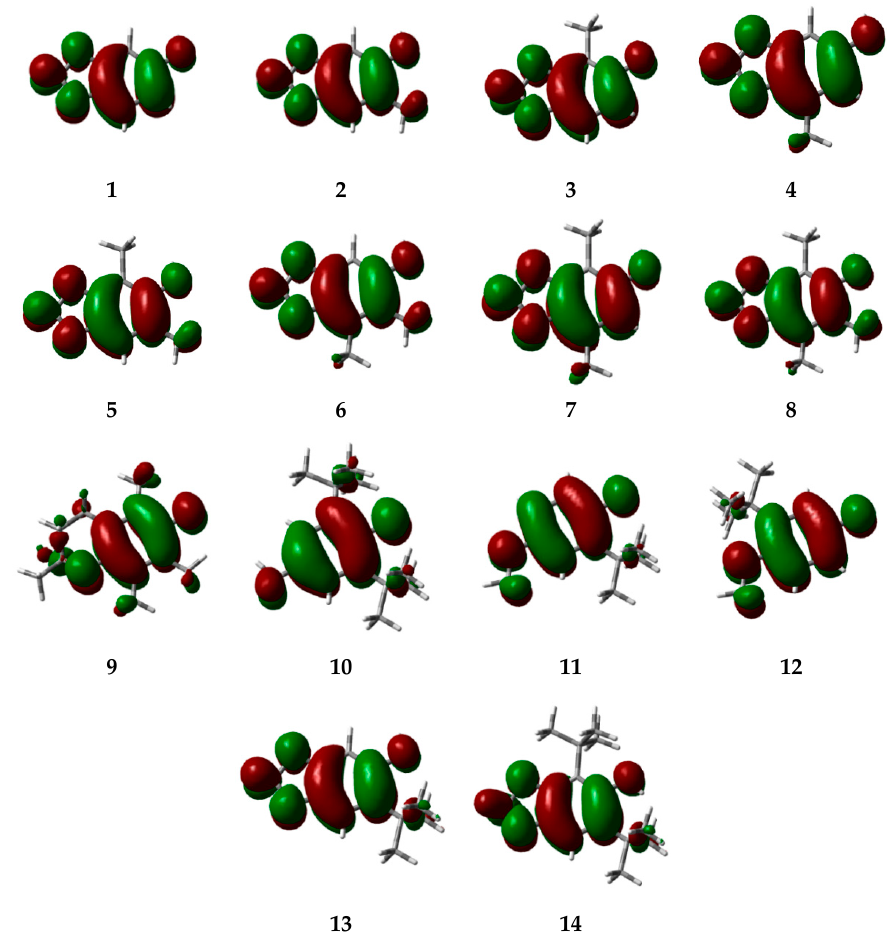
Figure 2. HOMO structure for sesamol, related alkylated derivatives, and classical antioxidants by B3LYP/6-31+G(d,p). 3D models of HOMO coefficients are in green and red.